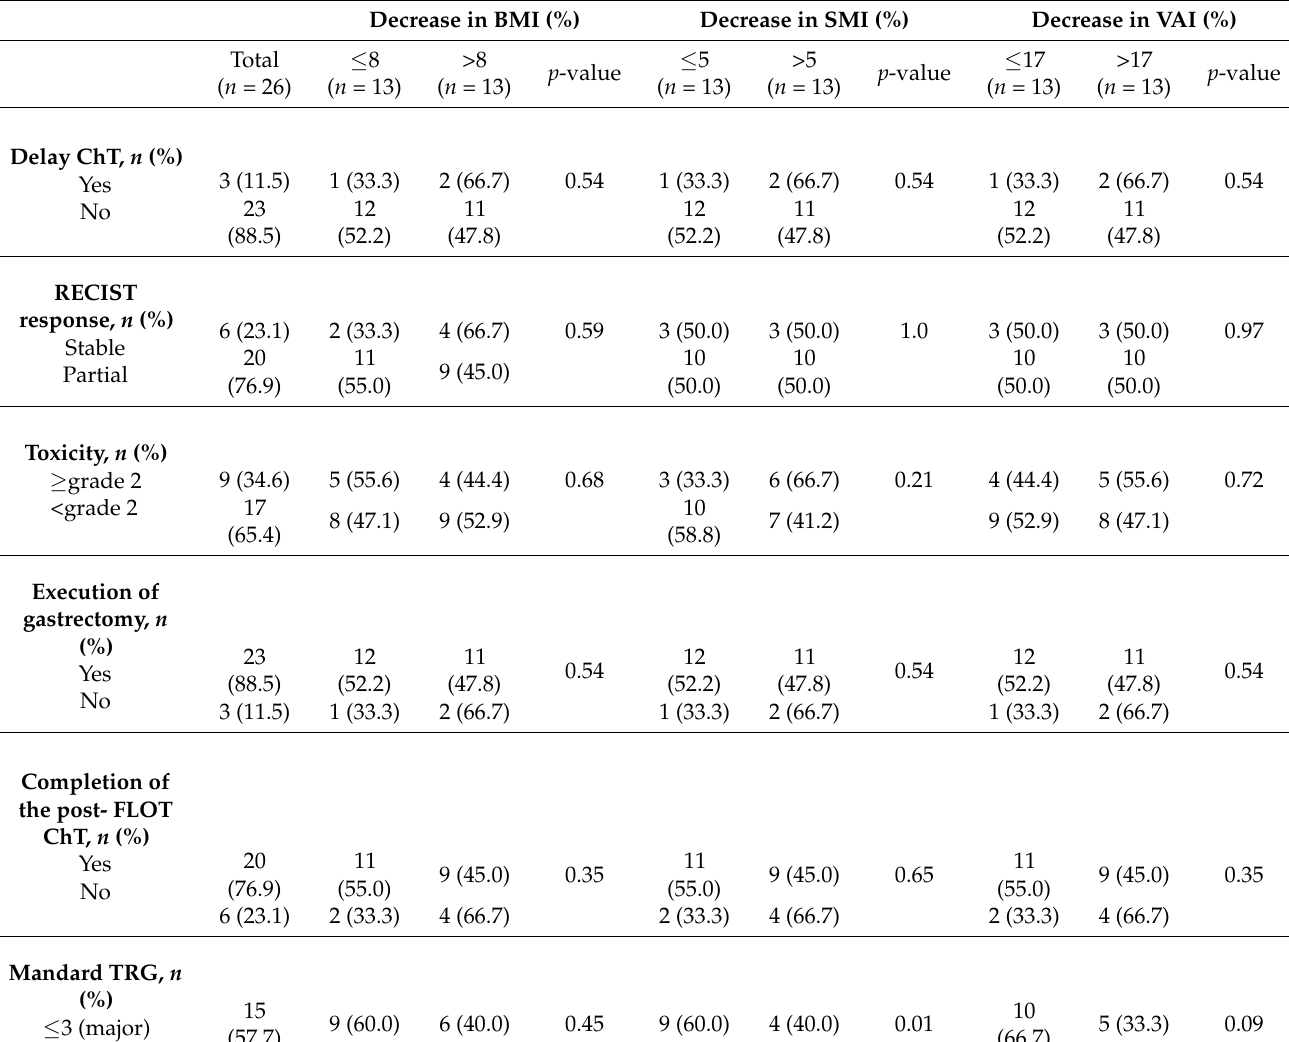
Table 3. Body composition changes and treatment